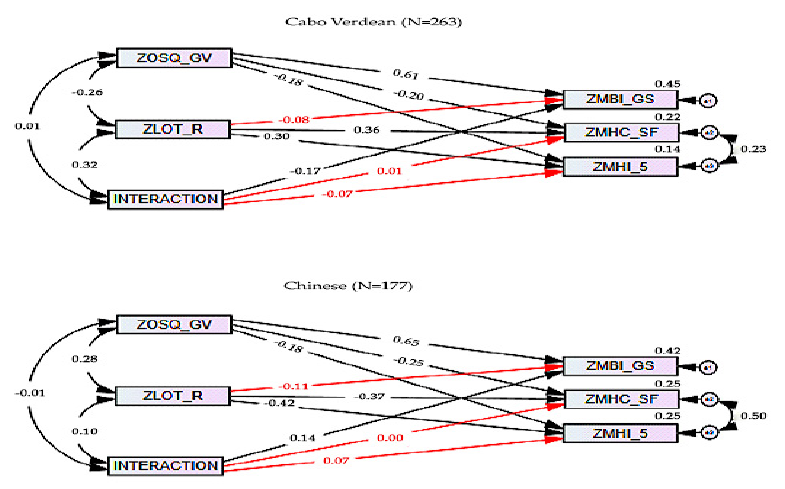
Figure A1. The moderation model of the test results. Note. ZOSQ—GV = occupational stress; ZLOT-R = optimism; ZMBI-GS = burnout; ZMHC—SF = positive mental health, ZMHI-5 = negative mental health relation (Z = means all variables are